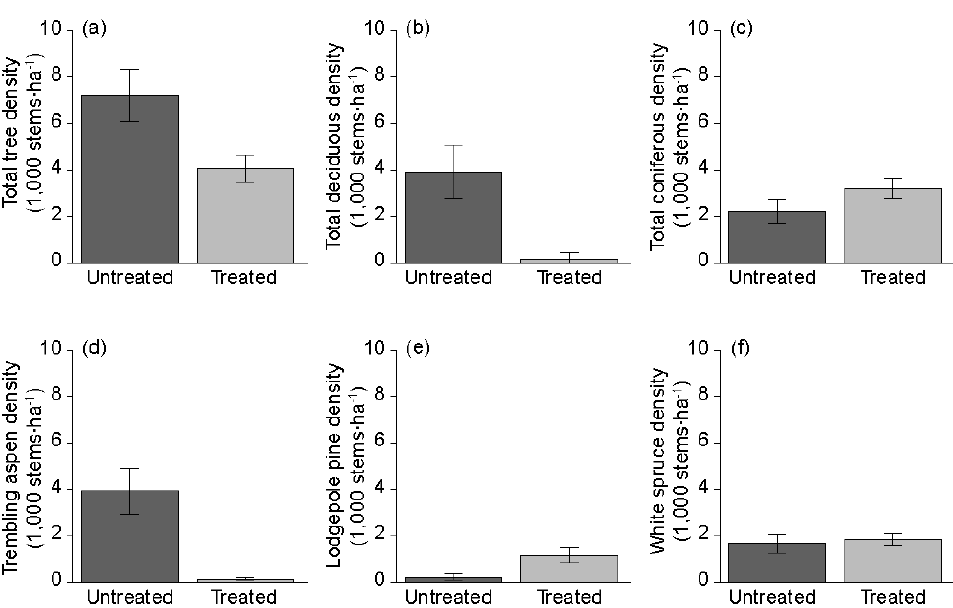
Figure 2. Average tree density comparisons in stems · ha − 1 contrasting untreated versus treated for: ( a ) all tree species; ( b ) deciduous trees; ( c ) coniferous trees; ( d ) trembling aspen ( Populus tremuloides Michx.); ( e ) lodgepole pine ( Pinus contorta Dougl. ex Loud. var. latifolia Engelm.) and ( f ) white spruce ( Picea glauca (Moench) Voss). Table 2. Average treatment stem density (stems · ha − 1 ) of major species groups and dominant tree species (trembling aspen ( Populus tremuloides Michx.), lodgepole pine ( Pinus contorta Dougl. ex Loud. var. latifolia Engelm.) and white spruce ( Picea glauca (Moench) Voss), with standard errors in parentheses; N = 8 (number of sites) within each